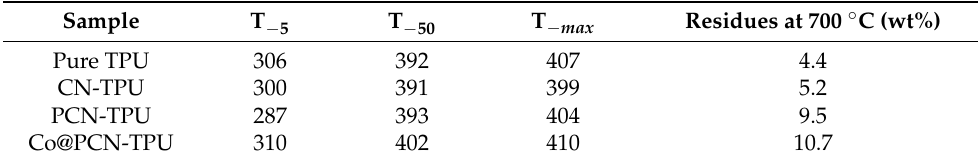
Table 3. The related data of TPU and its composites in nitrogen atmosphere.